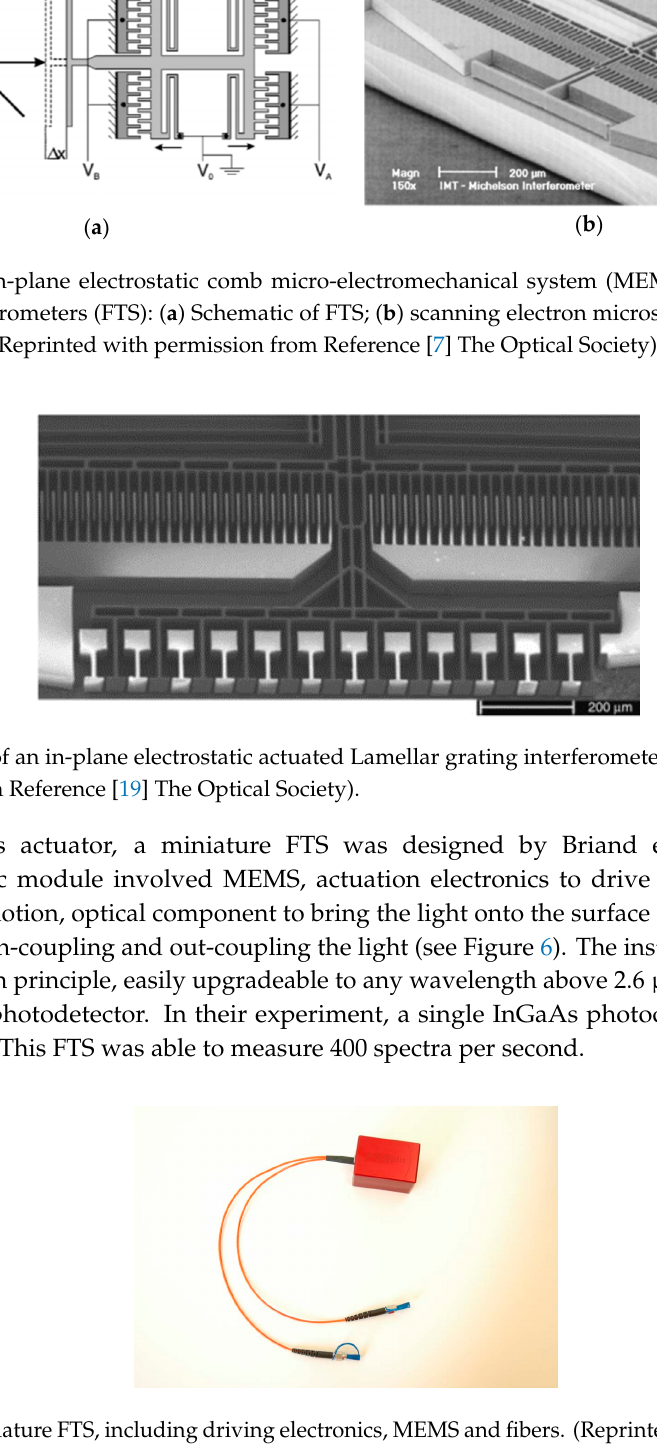
Figure 7. Portable FTS for near-infrared/mid-infrared (ARCspectro ANIR/AMIR) utilizing an in-plane electrostatic MEMS lamellar grating. (Reprinted with permission from Reference [30] SPIE).